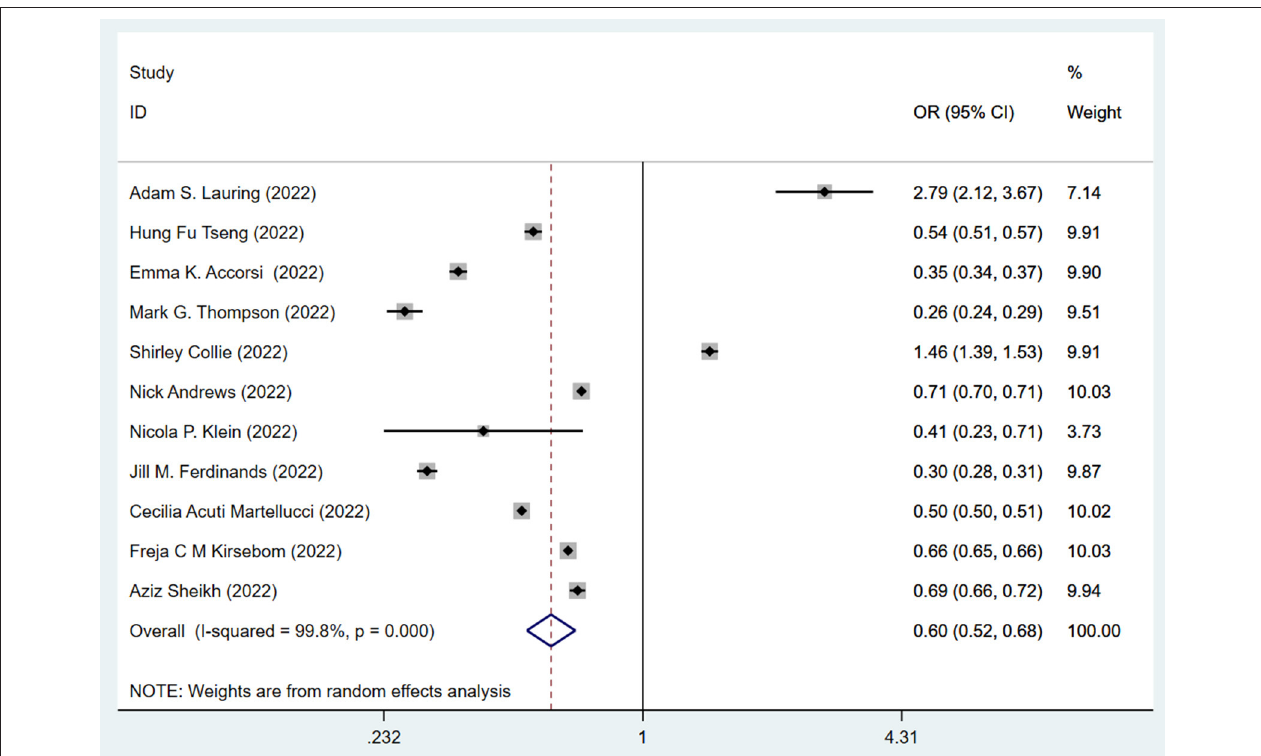
FIGURE 4 | Effectiveness of the three doses COVID-19 vaccines against the Omicron variant compared to the two doses only